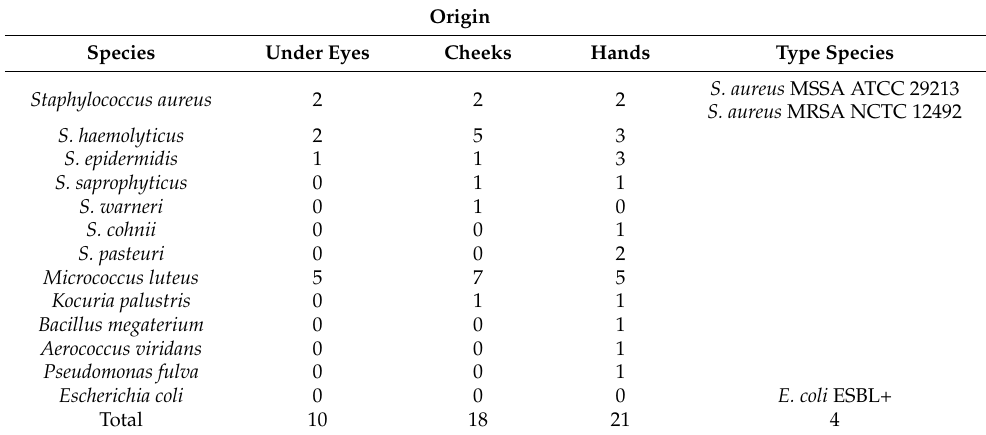
Table 5. Characteristics of the bacterial—commensal strains used in the analysis.